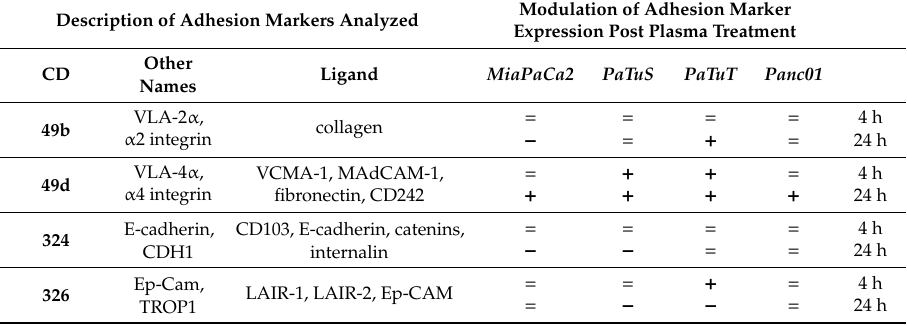
Table 1. Type and modulation of adhesion markers analyzed following plasma treatment. Type of four di ff erent adhesion molecules and their ligands, as well as the modulation of their expression 4 h or 24 h post-plasma treatment in four di ff erent human pancreatic cancer cell lines. An increase of the surface marker expression is indicated as “ + ”, una ff ected markers as “ = ”, and a reduction of marker expression as “ −